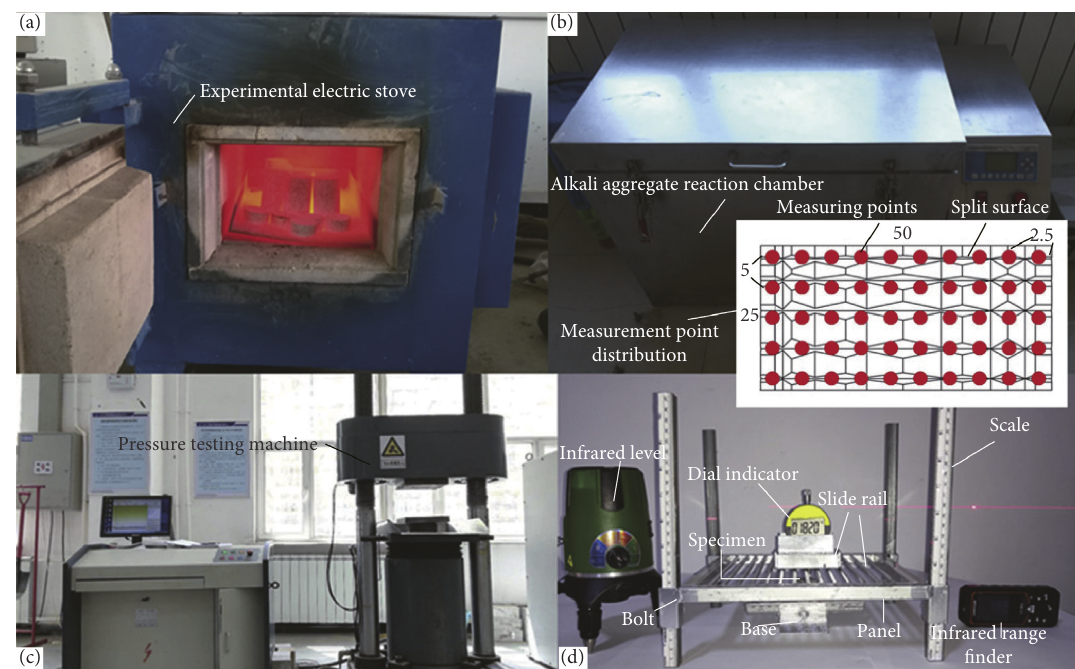
Figure 2: Test content. (a) Heating. (b) Cooling. (c) Brazilian disc test. (d) Roughness